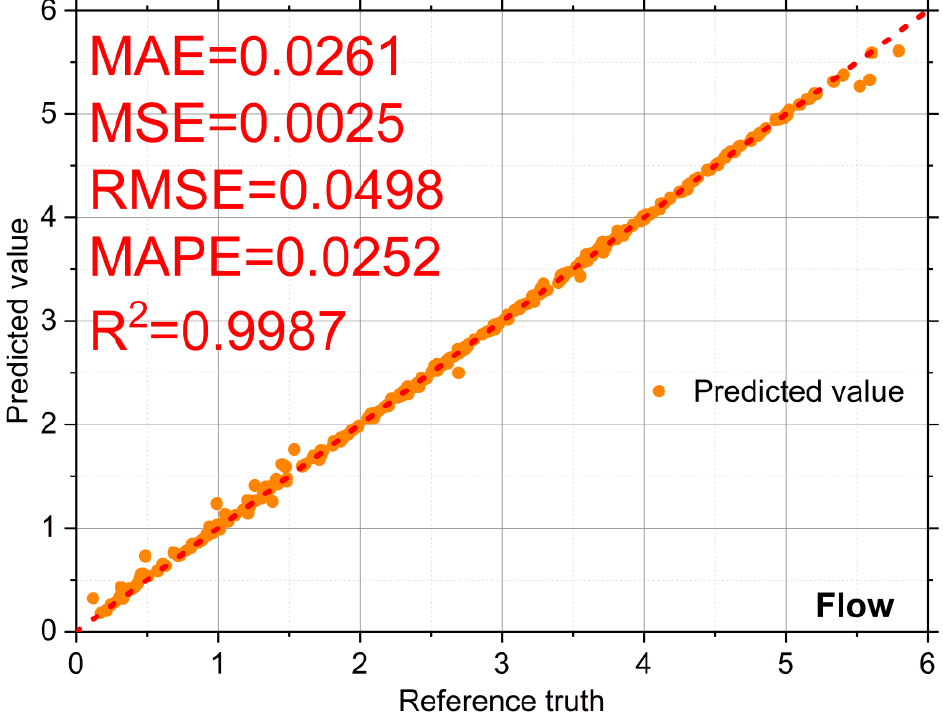
Figure 12. Accuracy of emitter flow rate prediction model based on simulation dataset.